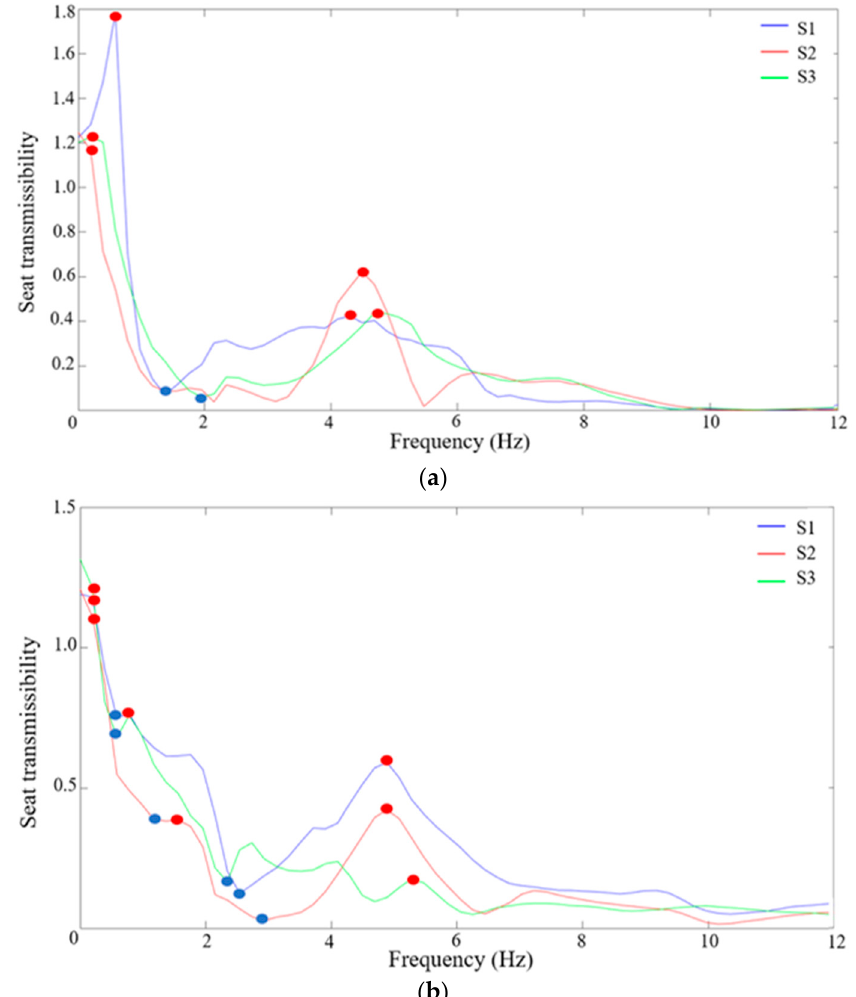
Figure 17. Transmissibility curves of Intercity train seat: ( a ) comfort seat; ( b ) standard seat. Table 3. Main resonance and antiresonance frequency values for comfort and standard seats of Intercity